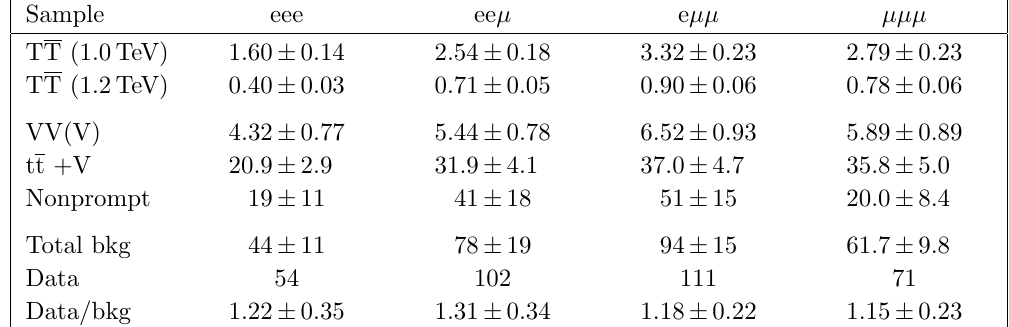
Table 7 . Numbers of predicted and observed events for lepton (cid:13)avor categories in the trilepton channel before the (cid:12)t to data. Uncertainties include both statistical and systematic components. Figure 8 shows 95% CL upper limits on the production of T and B quarks in the bench- mark branching fraction scenarios. We exclude singlet T quark masses below 1200 GeV (1160 GeV expected), doublet T quark masses below 1280 GeV (1240 GeV expected), sin- glet B quark masses below 1170 GeV (1130 GeV expected), and doublet B quark masses below 940 GeV (920 GeV